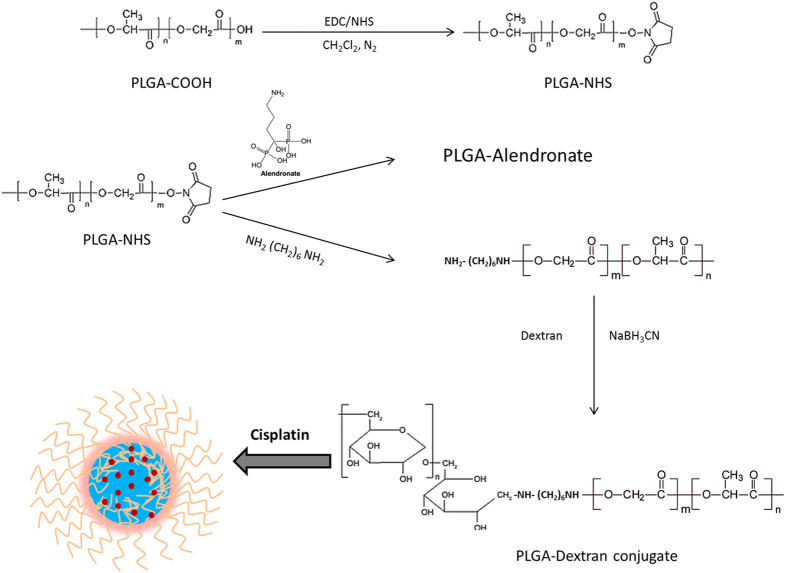
Schematic synthesis of poly (lactic-co-glycolic acid) (PLGA)-dextran sulphate (DS) block copolymer.The CDDP and PLGA-DS self-assembled to forms a polymeric nanoparticles in which PLGA forms the core and DS forms the outer surface.